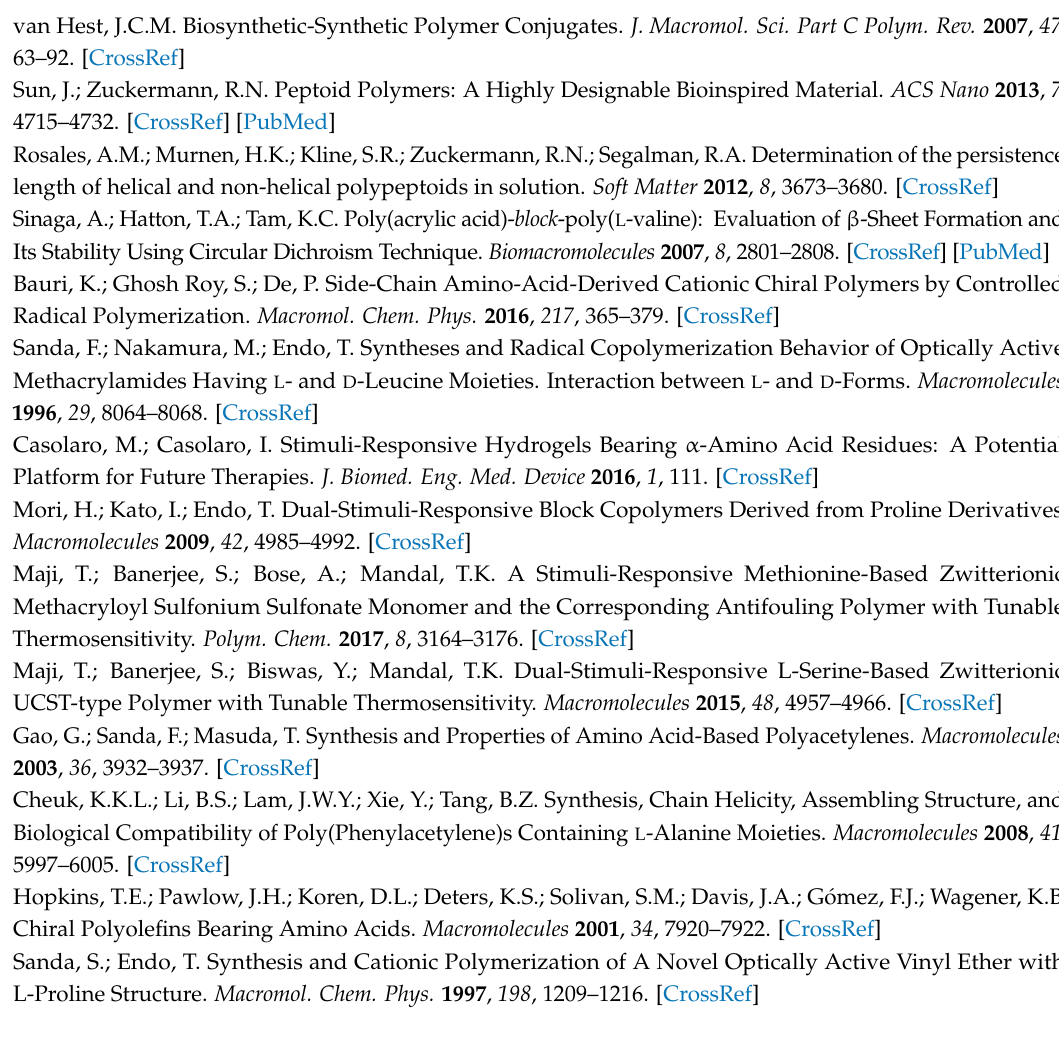
s1, Figure S1: 1 H-NMR spectra recorded in D 2 O at pH = 4.5, Figure S2: FTIR-ATR spectra of the investigated PAACs, Figure S3: Forward and backward titration curves referred to the 1st experiment of Table S1, Figure S4: Determination of β parameters for side -COOH and chain tert -amine of M- L -Ala, M- L -Val and M- L -Leu referred to the 1st experiment of Table S1: calculation of β values from Equation (S1b) (a–c); trend of the β -corrected pK a values versus α according to Equation (S1a) (d–f), Figure S5: pH Dependence of circular dichroism spectra of (a) M- L -Ala, (b) M- L -Val and c) M- L -Leu at 25 ◦ C, Figure S6: Comparison of the optimized geometry of M- L -Ala at pH 1 obtained in implicit water using the solvent dielectric constant (before simulations in explicit water) using the two simulation strategies described in the main text. In green the conformation obtained at 300 K, superimposed to the final geometry eventually obtained after the MD runs for 500 ps at 500 K, then for 500 ps at 400 K and finally 500 ps at 300 K (color codes: C atoms dark grey; H atoms light gray; N atoms blue; O atoms red) is shown. In the upper part of the figure, the superposition of the whole molecules is shown in CPK representation. The lower part reports the conformations of the main chain with no H atoms that were eventually achieved by the two strategies at 300 K viewed along three orthogonal directions; Table S1: PAAC pK a values from forward and backward titration